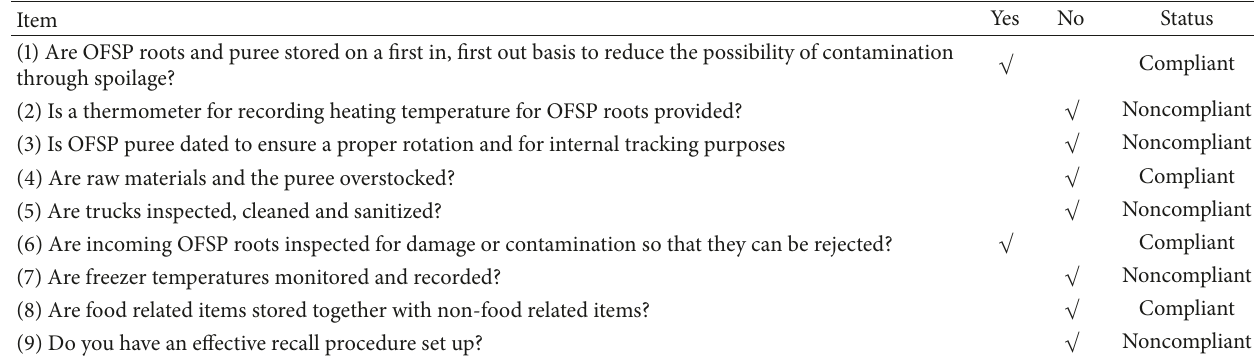
Table 8: Good Manufacturing Practices for process control in OFSP puree processing. Item Yes